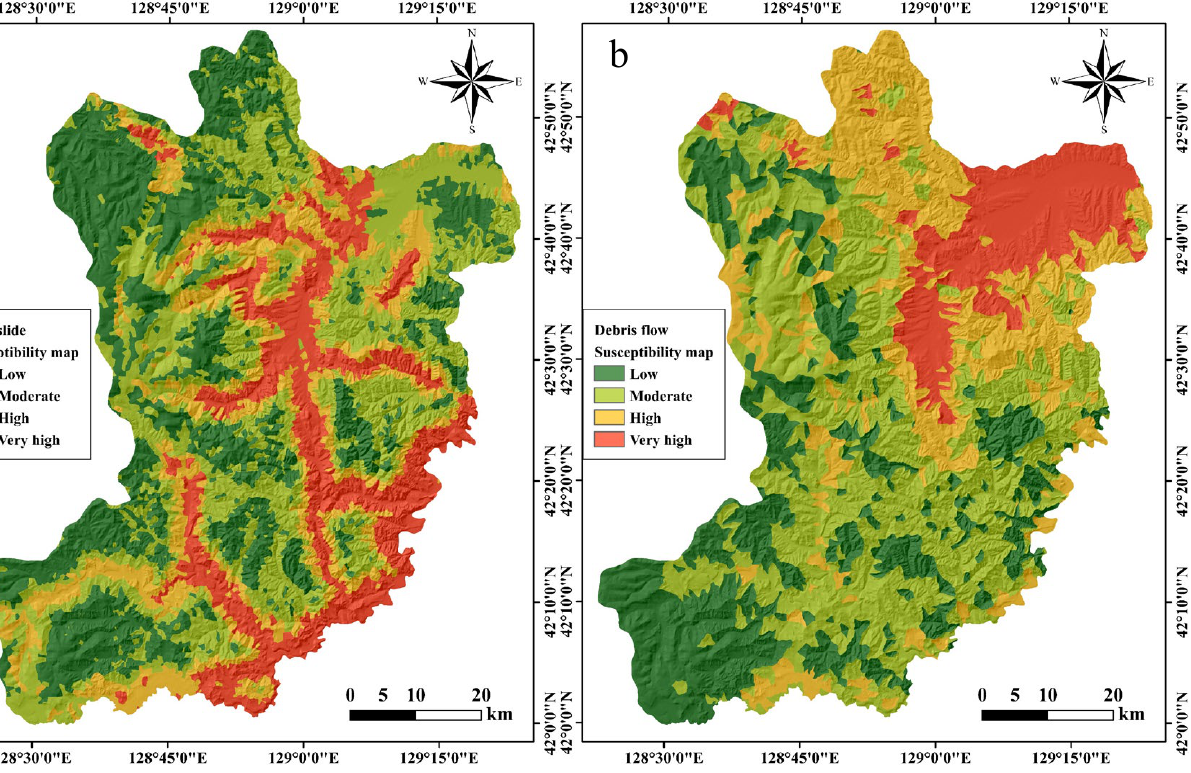
Figure 8. Geological hazard-susceptibility map: ( a ) landslide susceptibility map, ( b ) debris flow susceptibility map.